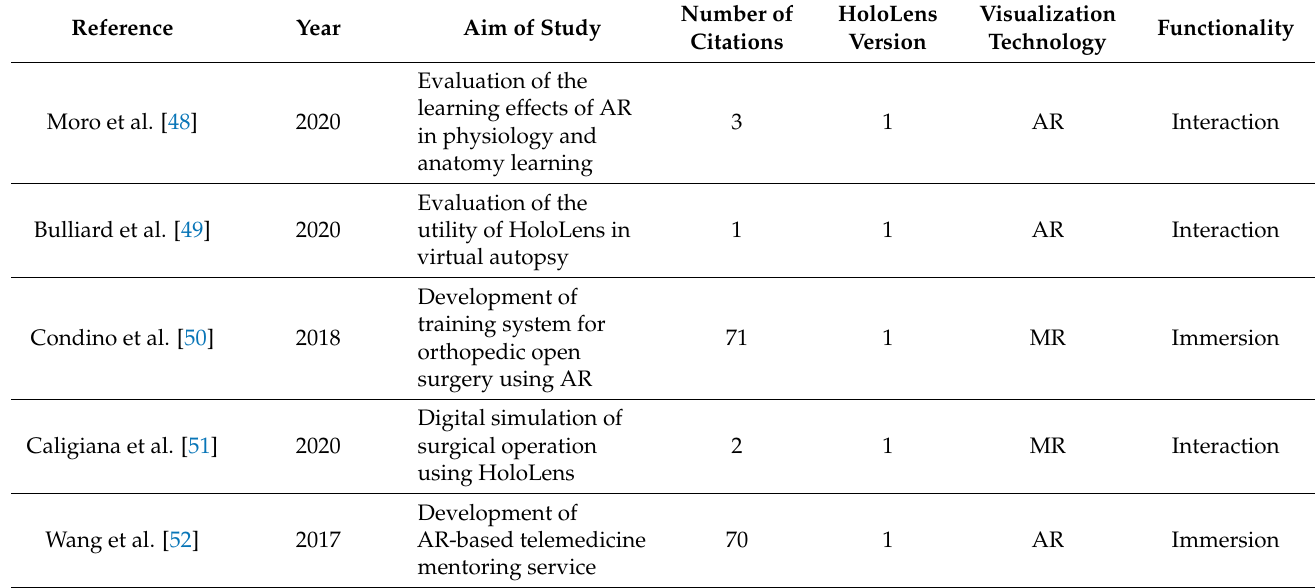
Table 3. Summary of Microsoft HoloLens application for medical education and simulation.